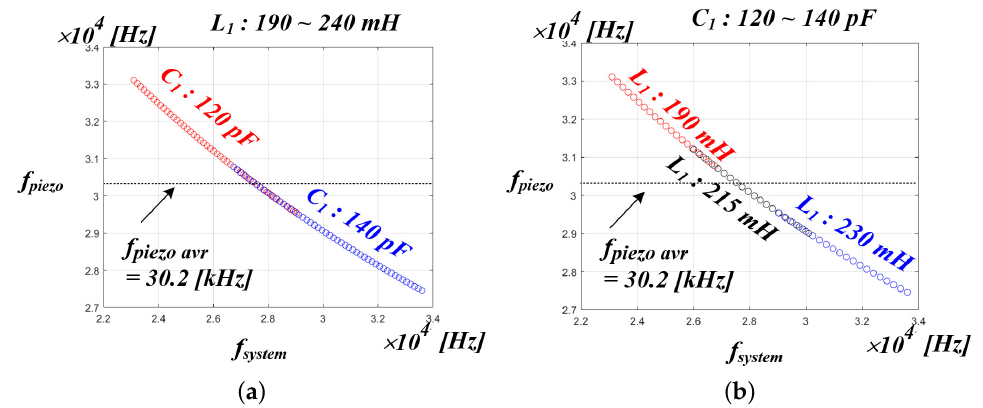
Figure 15. Range of PT resonance frequency according to L 1 and C 1 fluctuations for ( a ) C 1 —120,